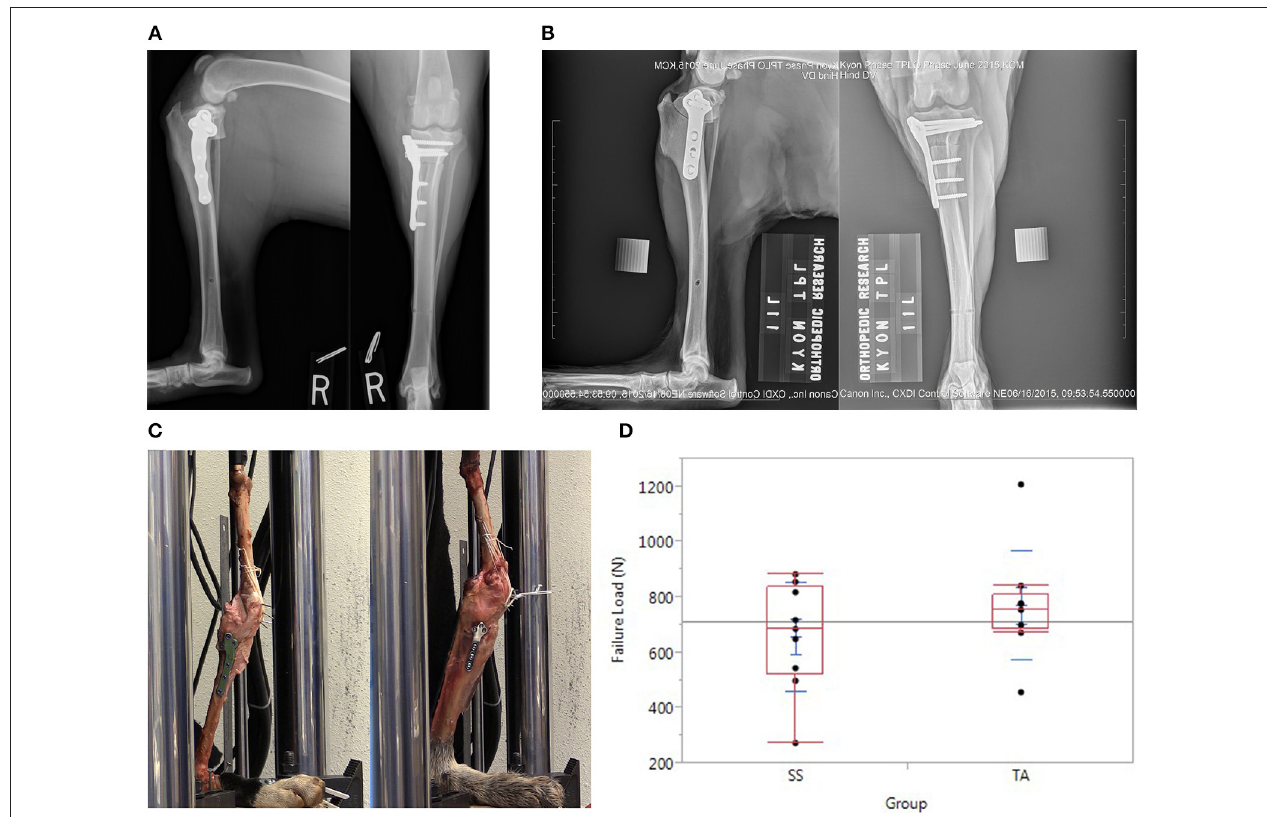
FIGURE 1 | (A) Orthogonal postoperative radiographs of a stifle in the TA group demonstrating plate placement with monocortical screws in the distal segment in accordance with manufacturer guidelines. (B) Orthogonal postoperative radiographs of a stifle in the SS group. (C) TPLO constructs positioned in servo-hydraulic testing machine before testing. (C) Left is an example of a construct in the TA group. (C) Right is an example of a construct in the SS group. (D) Graph depicting the load at the time of failure after TPLO with an established stainless steel plate (SS group) vs. a novel titanium alloy plate with mono-cortical locking screws (TA